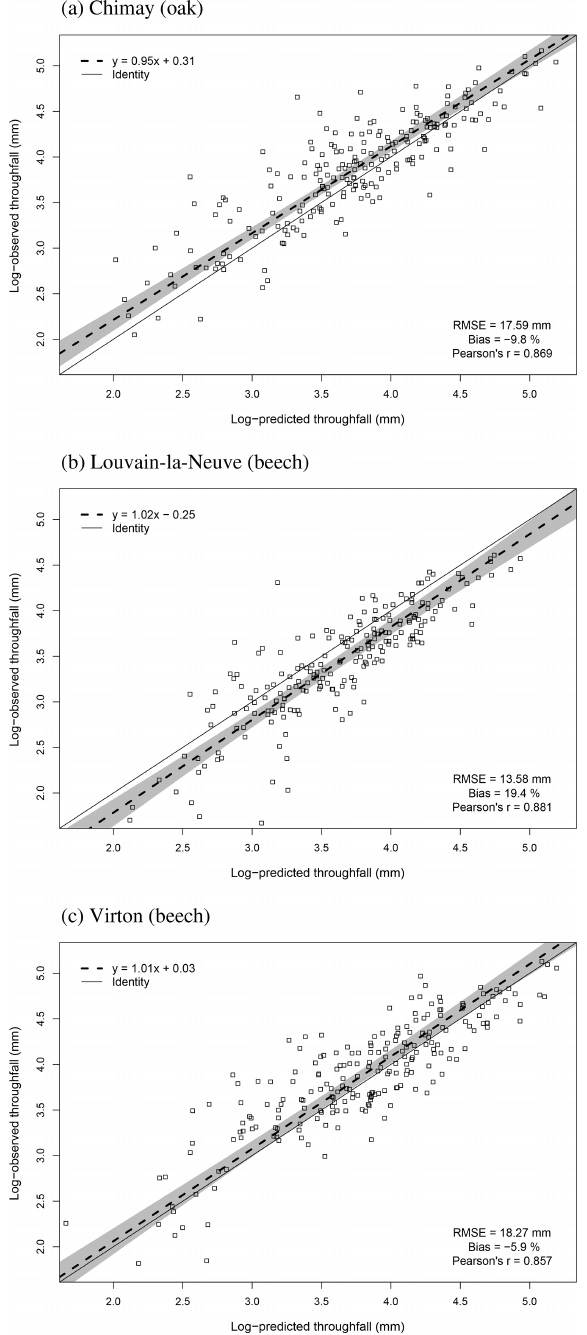
Figure B1. Comparison of the log-transformed observed and predicted monthly throughfall in Chimay (sessile oak), Louvain-la-Neuve (European beech) and Virton (European beech) between 2000 and 2016. The shaded area represents the confidence interval of the Deming regression (95%) of observations on predictions, and the solid line corresponds to the identity